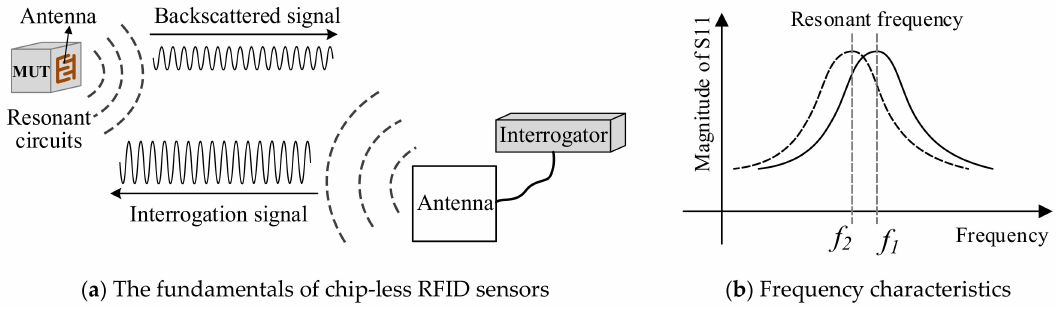
Figure 3. Chip-less RFID Sensors—Fundamentals and Frequency